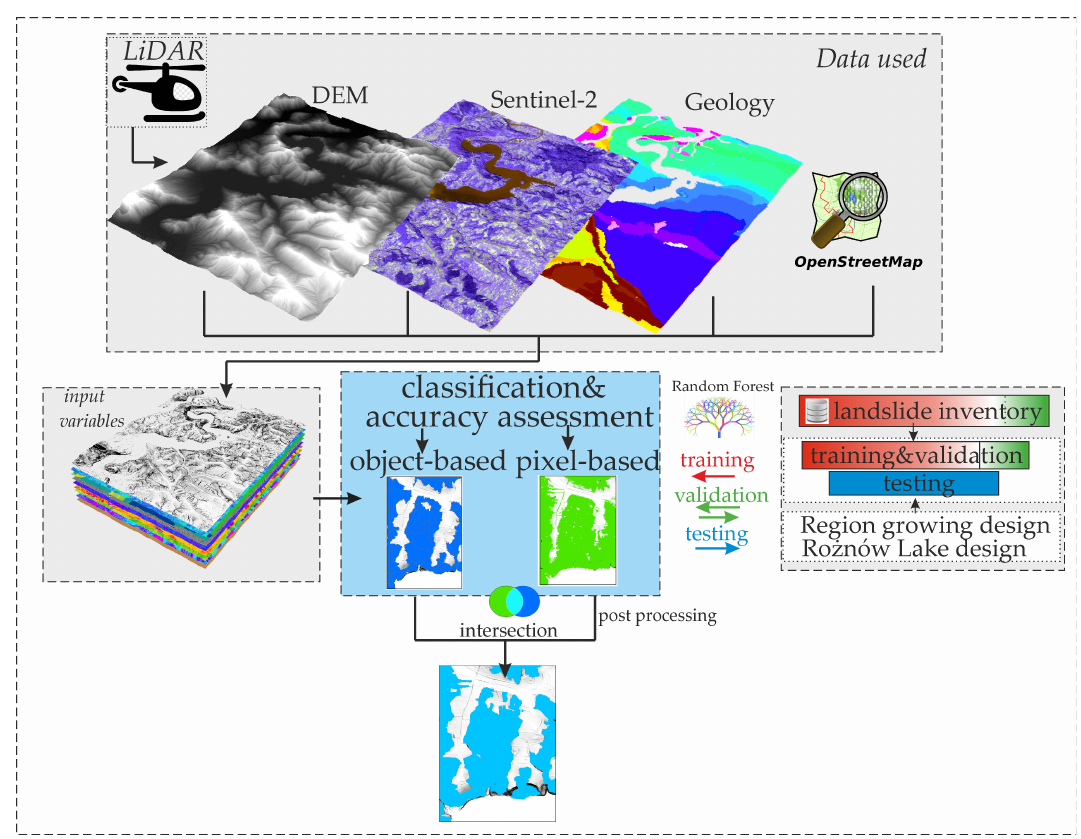
Figure 2. Overview of the entire methodology carried out in the present